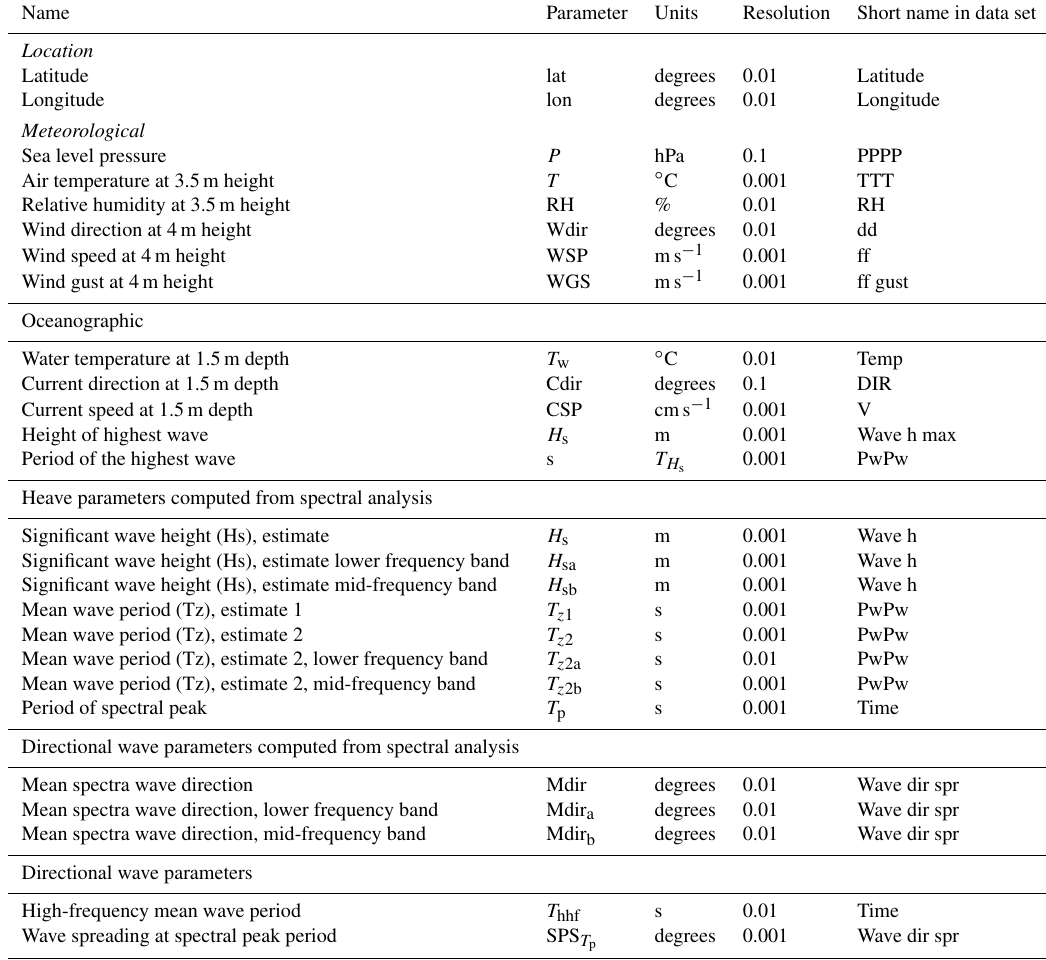
Table 2. Buoy measurements, units, resolution and short names used in the hourly data set.